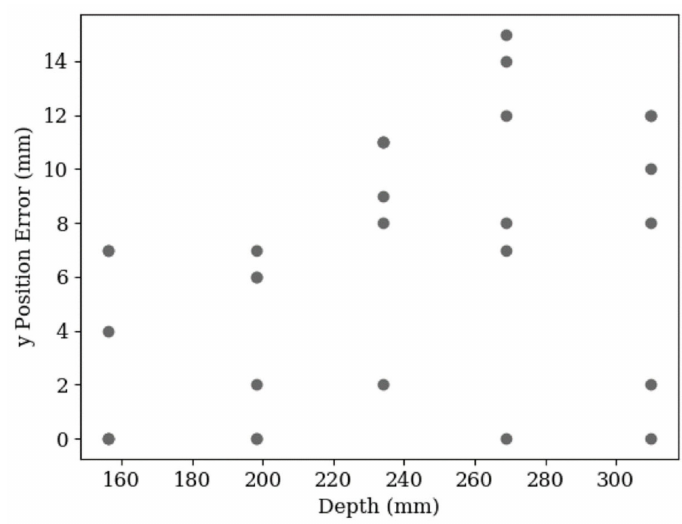
Figure 17. A scatter plot of the y-axis error in 30 leaf position estimations against depth. The data shows a spread from 0 mm to 15 mm. The RMS error is 8 mm.